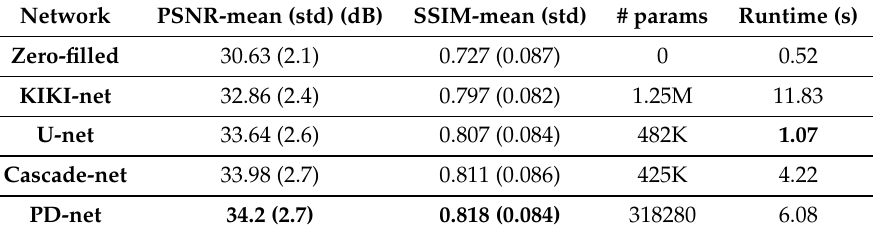
Table 3. Quantitative results for the fastMRI dataset with the Proton density (PD) contrast. PSNR and SSIM mean and standard deviations are computed over the 100 validation volumes. Runtimes are given for the reconstruction of a volume with 40